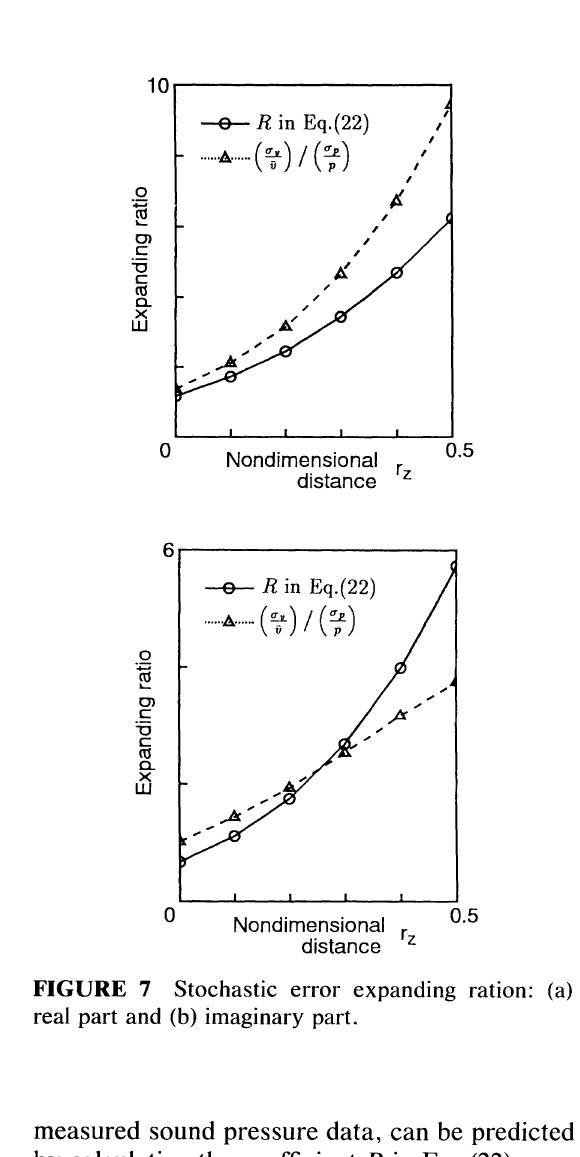
FIGURE 7 Stochastic error expanding ration: (a) real part and (b) imaginary